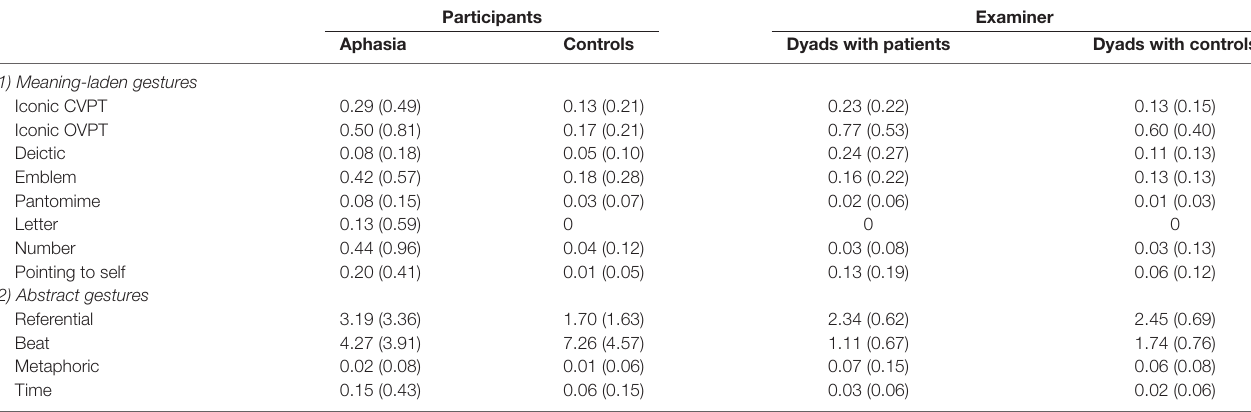
TABLE 2 | Relative gesture frequency per gesture category per 100 words (Standard deviations in